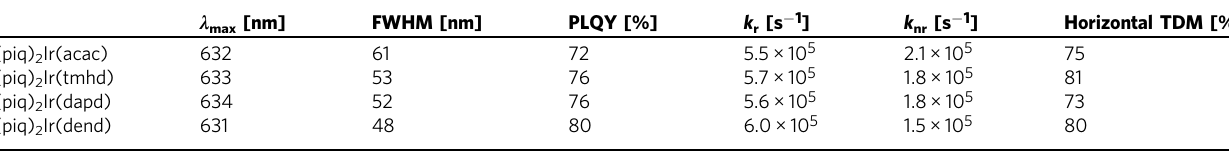
Table 1 Optical properties of the Ir(III)